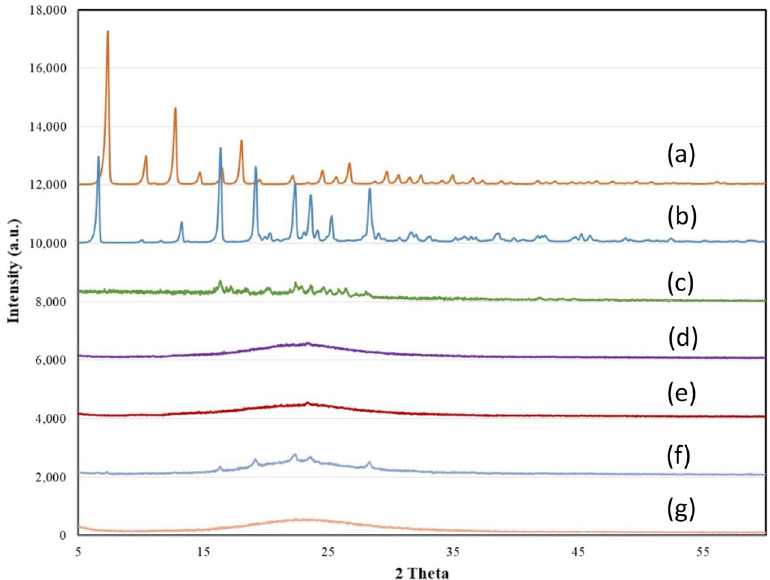
Figure 1. X-ray diffraction pattern of (a) ZIF-8, (b) Resveratrol, (c) Curcumin, (d) MCM-41/ZIF-8/Curcumin, (e) KIT-6/ZIF-8/Curcumin, (f) MCM-41/ZIF-8/Resveratrol and (g) KIT-6/ZIF-8/Resveratrol nanocomposites.